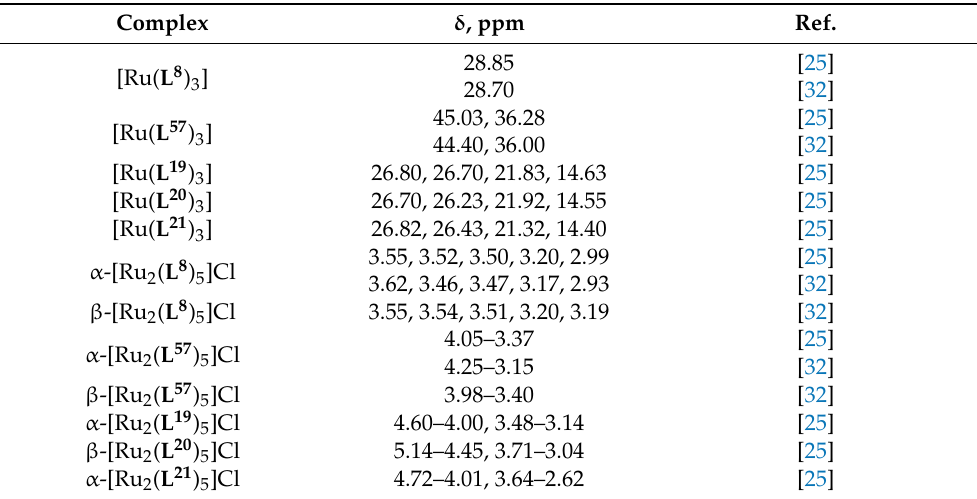
Table 9. 1 H Chemical shifts of α -hydrogen nuclei for a series of ruthenium(III) dithiocarbamate complexes.